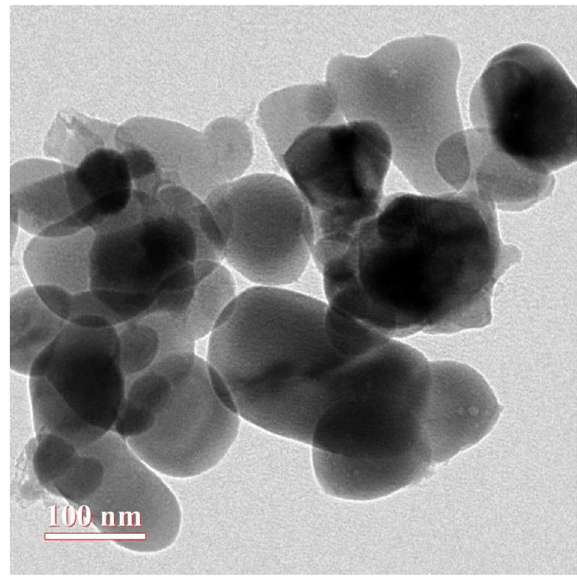
Figure 5: HR - TEM image of biogenic ZnO NPs.